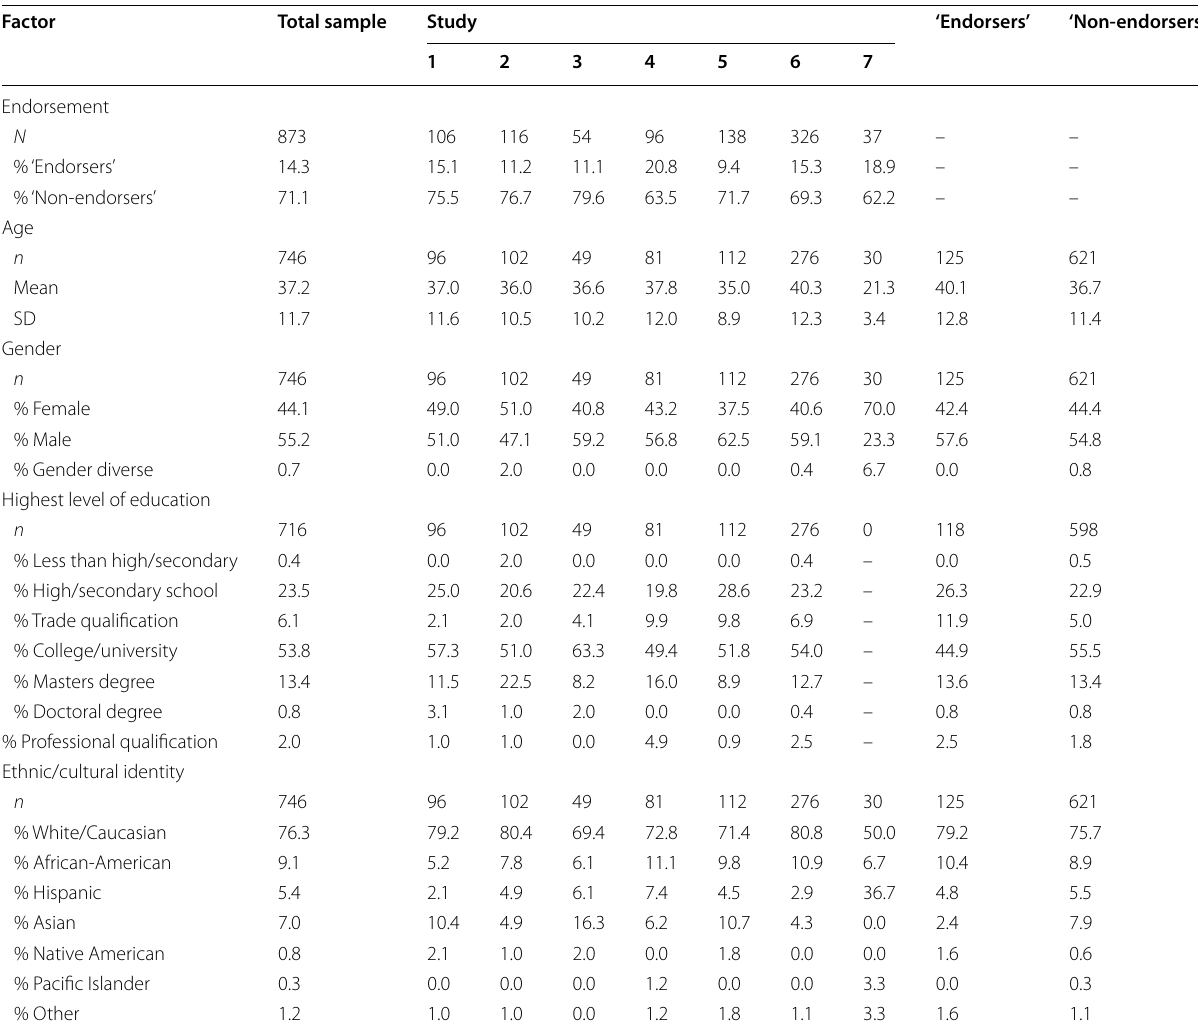
Table 2 Participant demographic